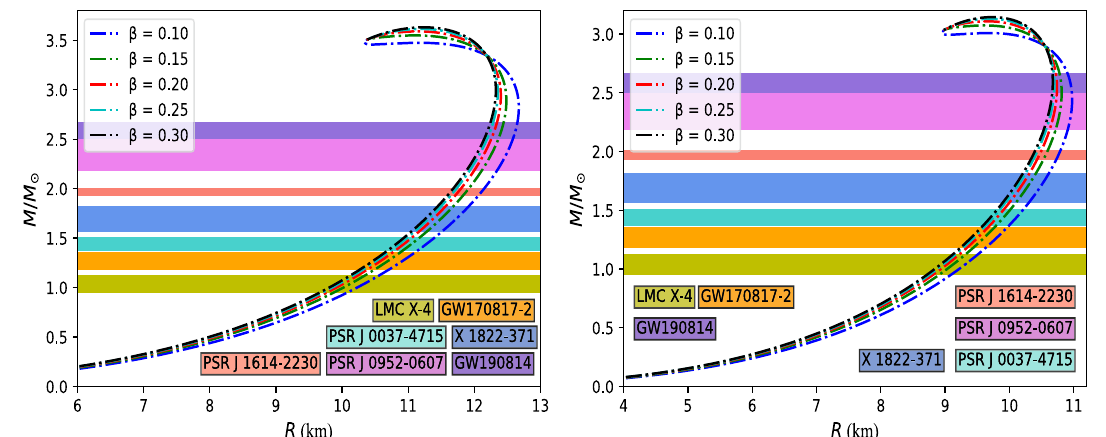
Fig. 9 The variation of Mass ( M / M (cid:8) ) versus Radius ( R ) for solution 5.1, left panel for ρ s (cid:12) 6 × 10 14 gm / cm 3 and right panel for ρ s (cid:12)